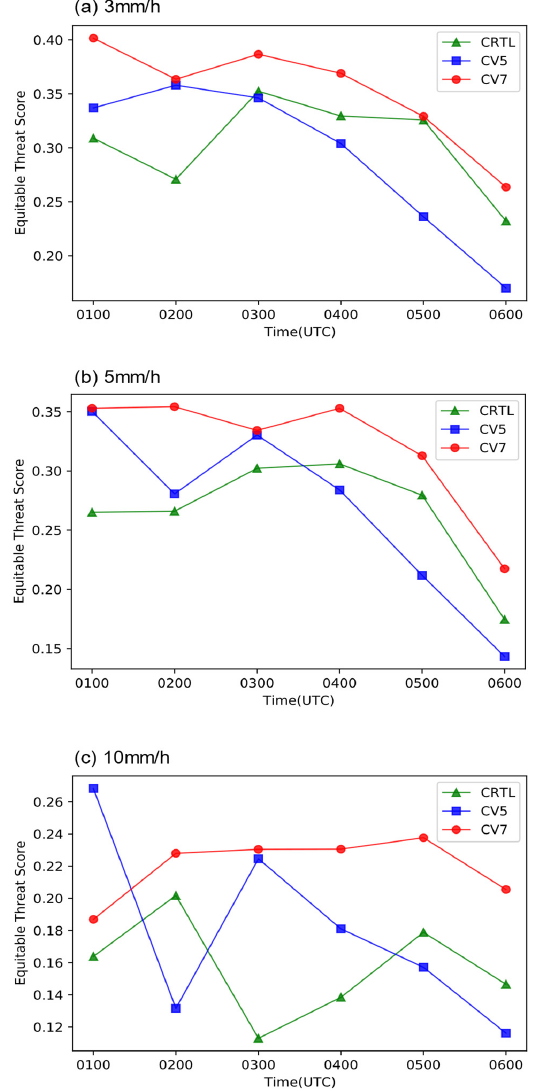
Figure 14. ETSs of 1-h accumulated precipitation from 0100 UTC to 0600 UTC at the 3 mm − 1 ( a ), 5 mm − 1 ( b ) and 10 mm − 1 ( c ) thresholds for three experiments (CTRL: green line, ψ − χ control variable: blue line, U − V control variable: red